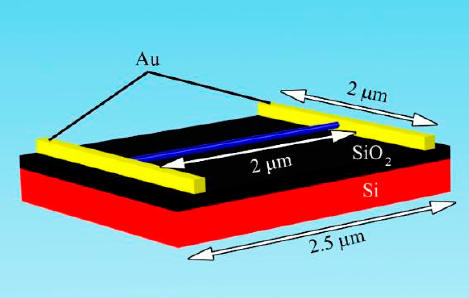
Figure 1. 3D scheme of the single-wire model between to metal contacts used for FEM simulations. Reproduced from Ref. [40], with permission from